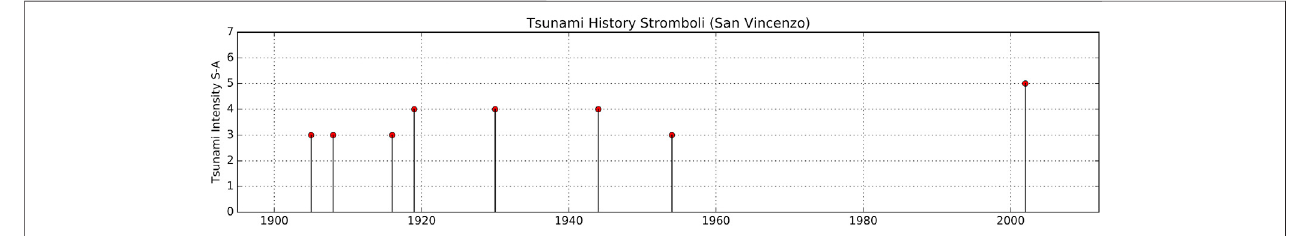
FIGURE 5 | Tsunami history of